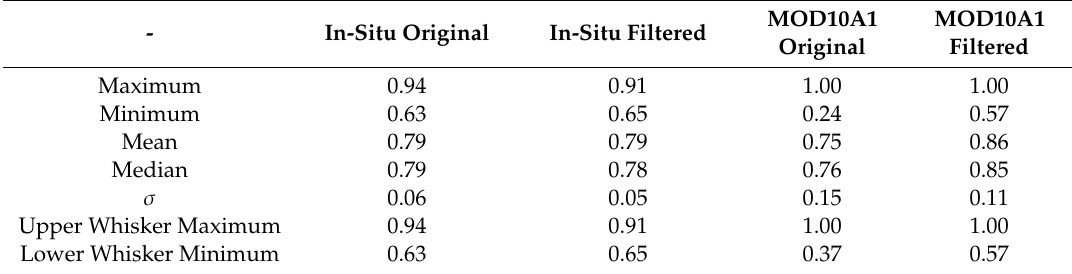
Table 6. Statistical data of in-situ and MOD10A1 albedo data before and after filtering. σ is the standard